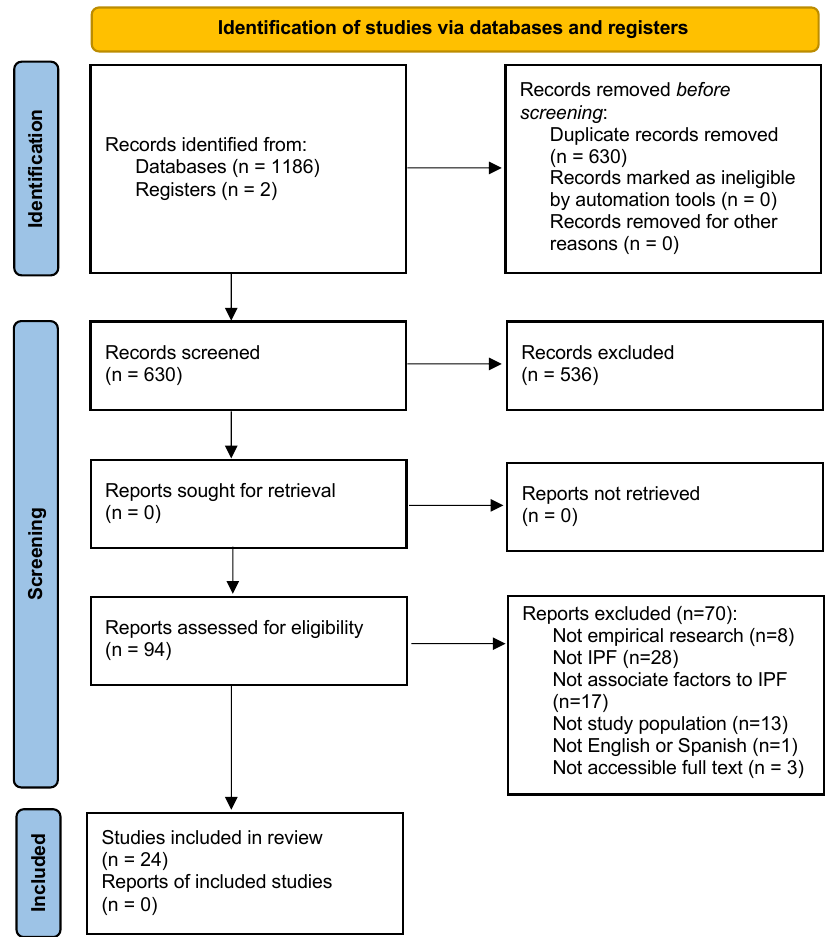
Figure 1. PRISMA flow diagram of the studies’ selection process